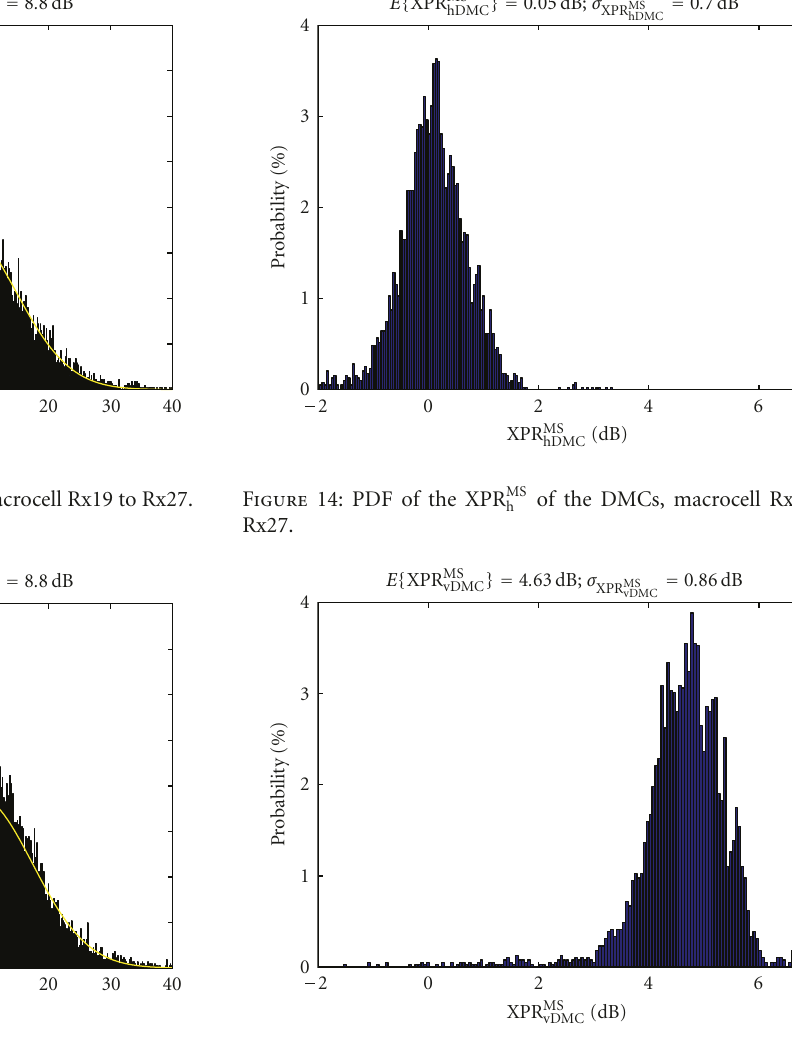
of the SCs, macrocell Rx19 to Rx27. v